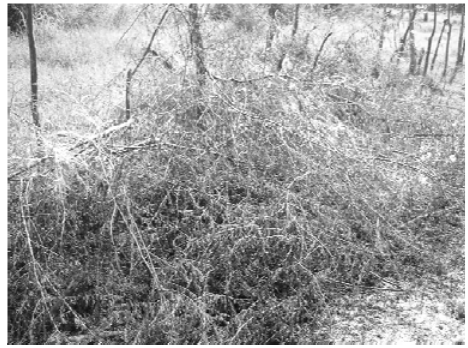
Figure 7. Elimination of Marabú by cutting.